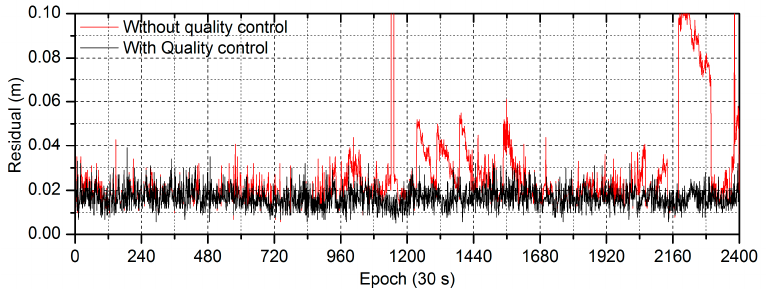
Figure 3. The unit weight STD of the single GPS PPP solution with and without quality control at station BRST.